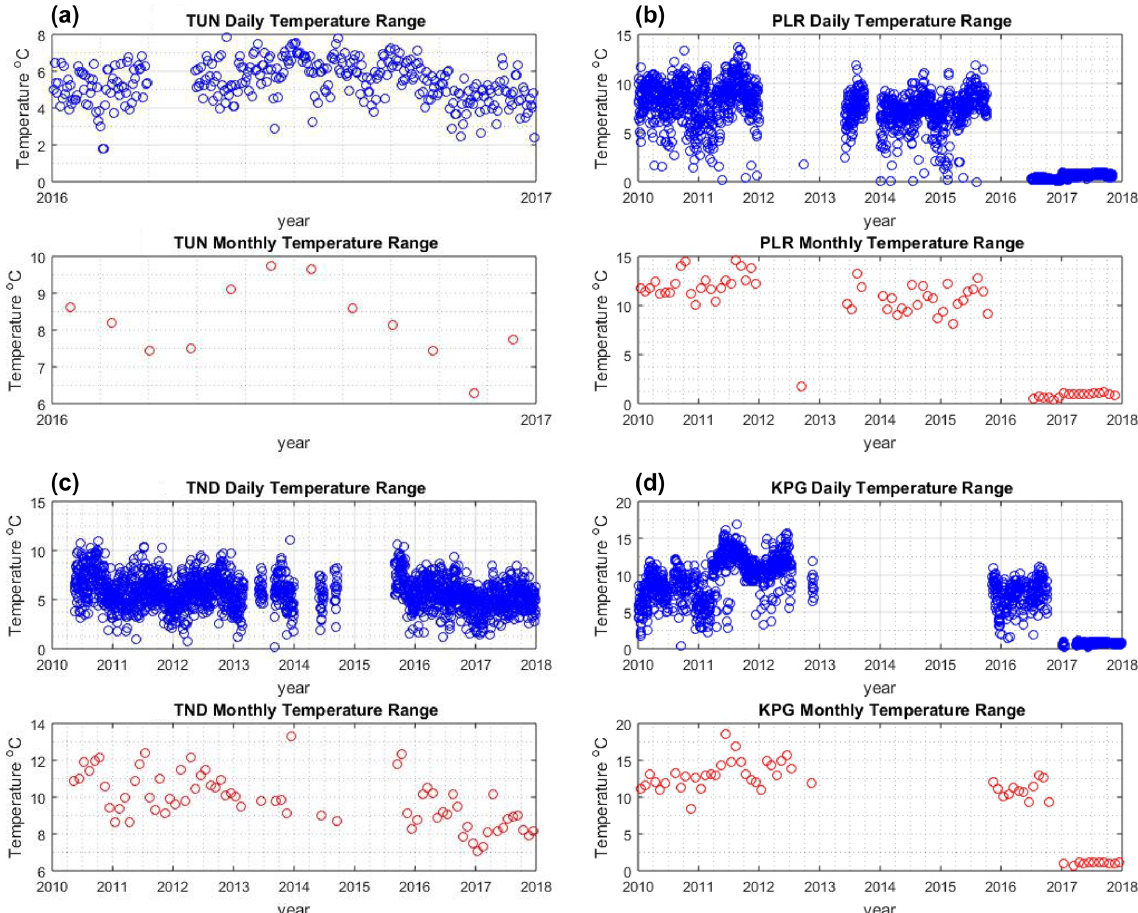
Figure 8. Daily range (blue circle) and monthly range (red circle) of temperature from four Indonesian observatories. The panels show data from (a) TUN, (b) PLR, (c) TND, and (d)